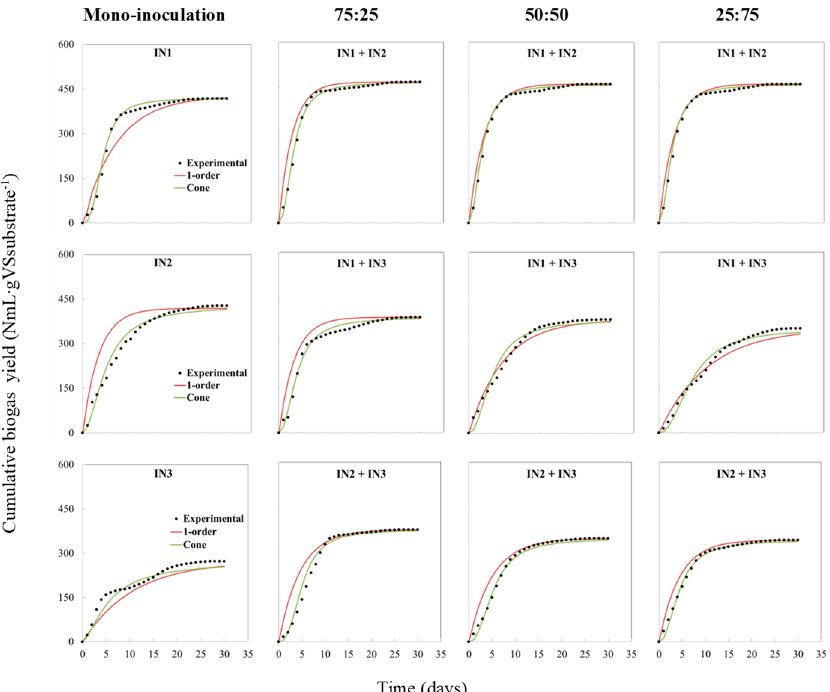
Figure 6. Plots of the measured and the predicted biogas yields from the reactors treating PFSF inoculated with three different inoculums and their mixtures (IN1, digestate from the reactor treating the activated sludge; IN2, digestate from the reactor treating the organic fraction of MSW; and IN3, digested cow manure).